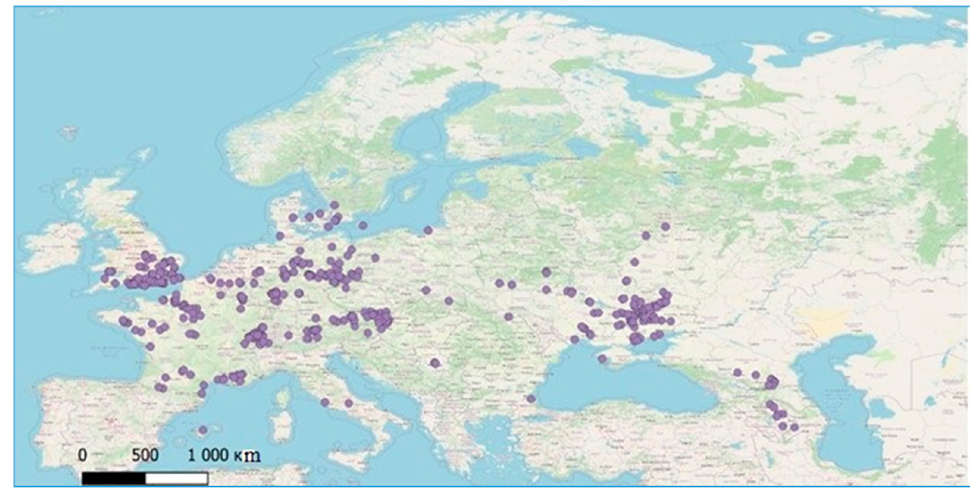
Figure 1. Points of occurrence of Z. tenebrioides .